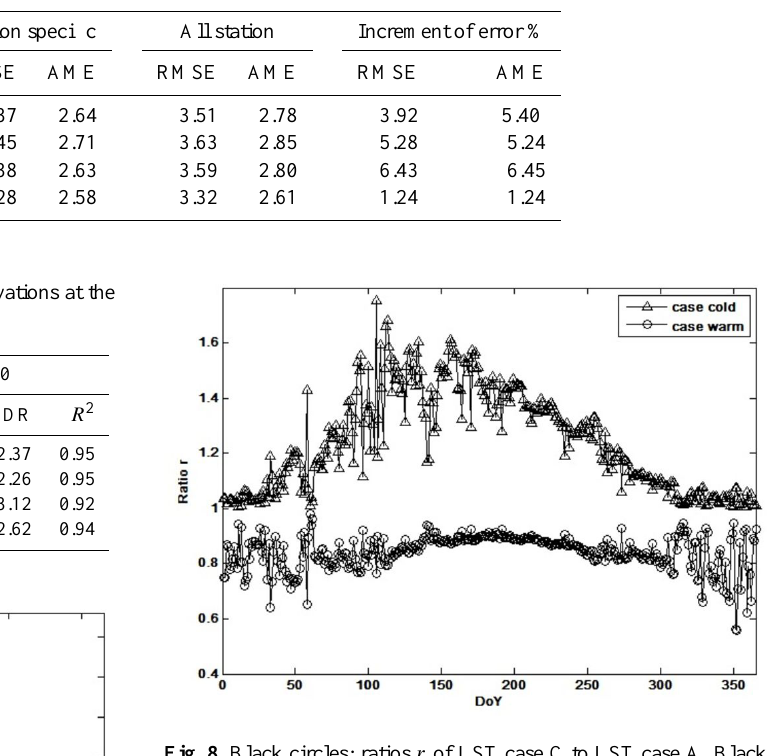
Fig. 8. Black circles: ratios r of LST case C to LST case A. Black triangles: ratios r of LST case C to LST case B. LST for cases A, B and C shown in Fig.